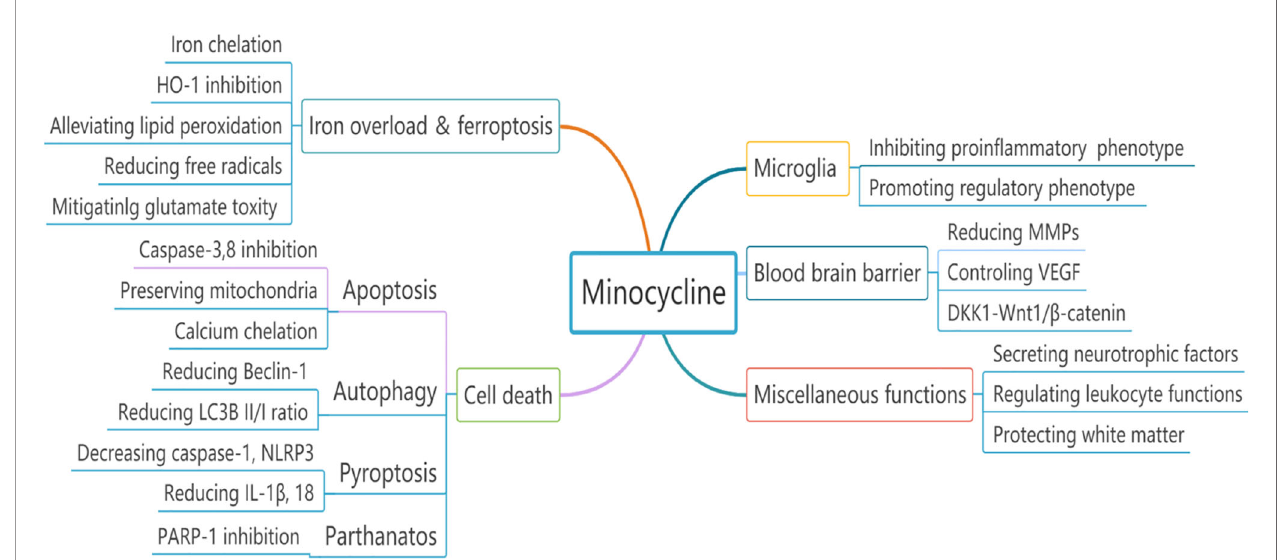
FIGURE 2 | The neuroprotective effects of minocycline in experimental ICH could be attributed to multiple divergent